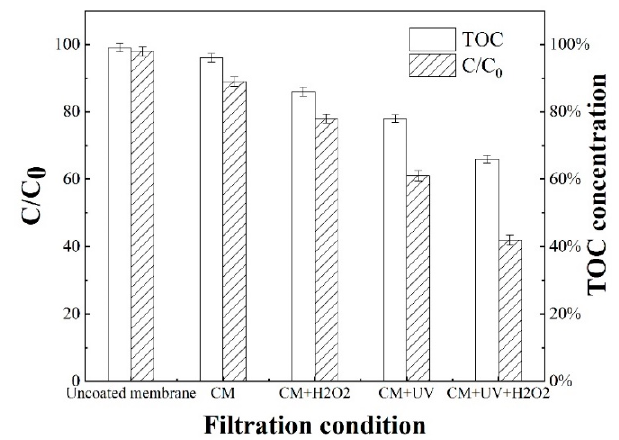
Figure 3. The removal of SMX under different filtration conditions: SMX concentration: 20 mg·L − 1 ; Influent flux: 10 LMH; UV intensity: 401 µ W · cm − 2 ; H 2 O 2 dosage: 10 mmol · L − 1 at 5 ± 0.2 µ L · s − 1 and CM denotes for coated membrane.